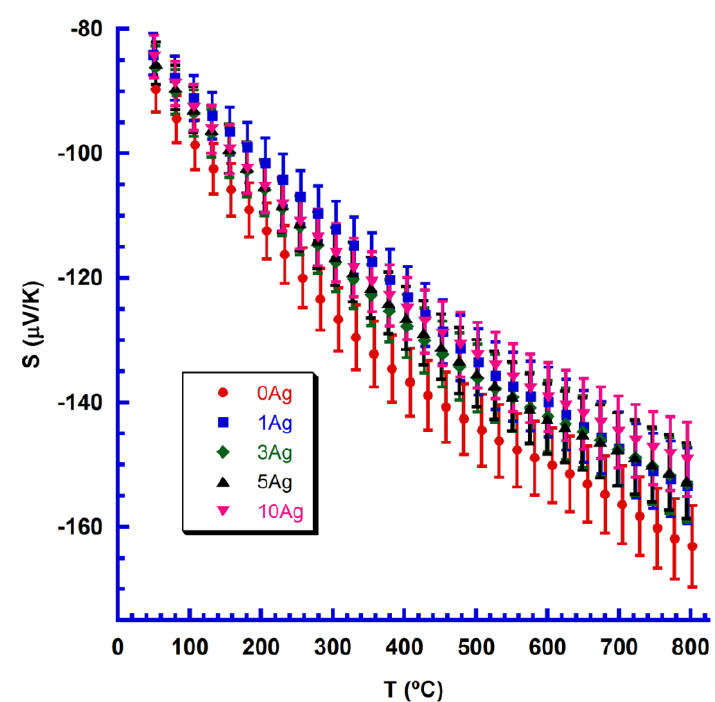
Figure 5. Seebeck coefficient change with temperature for Ca 0.9 Yb 0.1 MnO 3 + x wt.% Ag samples (given as a function of Ag content), together with their measurement errors.